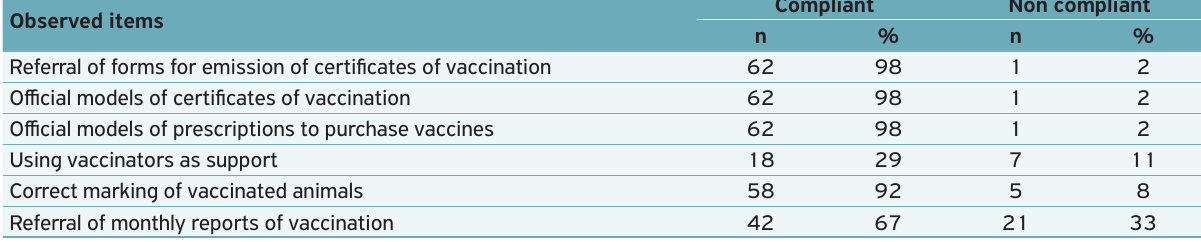
Table 3. Procedures for vaccination of calves performed by veterinarians qualified to act on the National Programme for Control and Eradication of Animal Brucellosis and Tuberculosis according to the records of inspection applied by the Institute of Agricultural and Forestry Defense of the Espírito Santo state, Brazil, between 2008 and